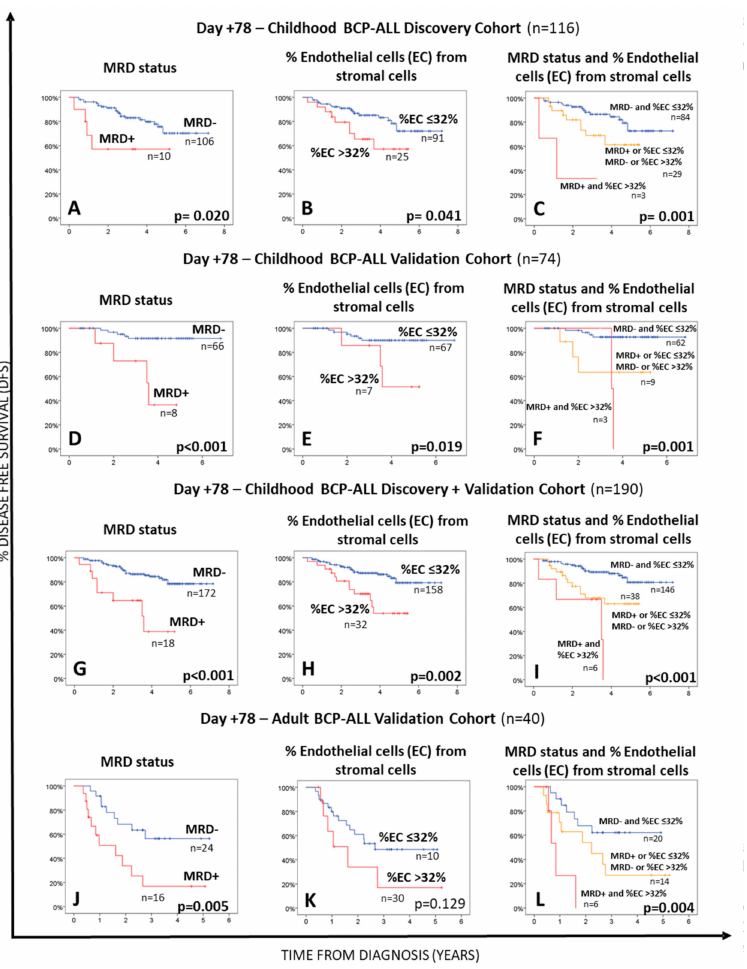
Figure 2. Impact of the BM MRD status Panels ( A , D , G , J ), the percentage of BM endothelial cells Panels ( B , E , H , K ) within the whole BM stromal cell compartment at day +78 or both parameters Panels ( C , F , I , L ) on disease free survival (DFS) of BCP-ALL patients. Panels ( A – C ) show data for the discovery patient cohort, while ( D – F , J – L ) panels display survival curves for the validation cohorts of childhood and adult BCP-ALL patients, respectively. DFS curves of all childhood BCP-ALL cases (the discovery plus the validation cohorts) are shown in panels ( G – I ). Statistical significance was set at p < 0.05 (log rank